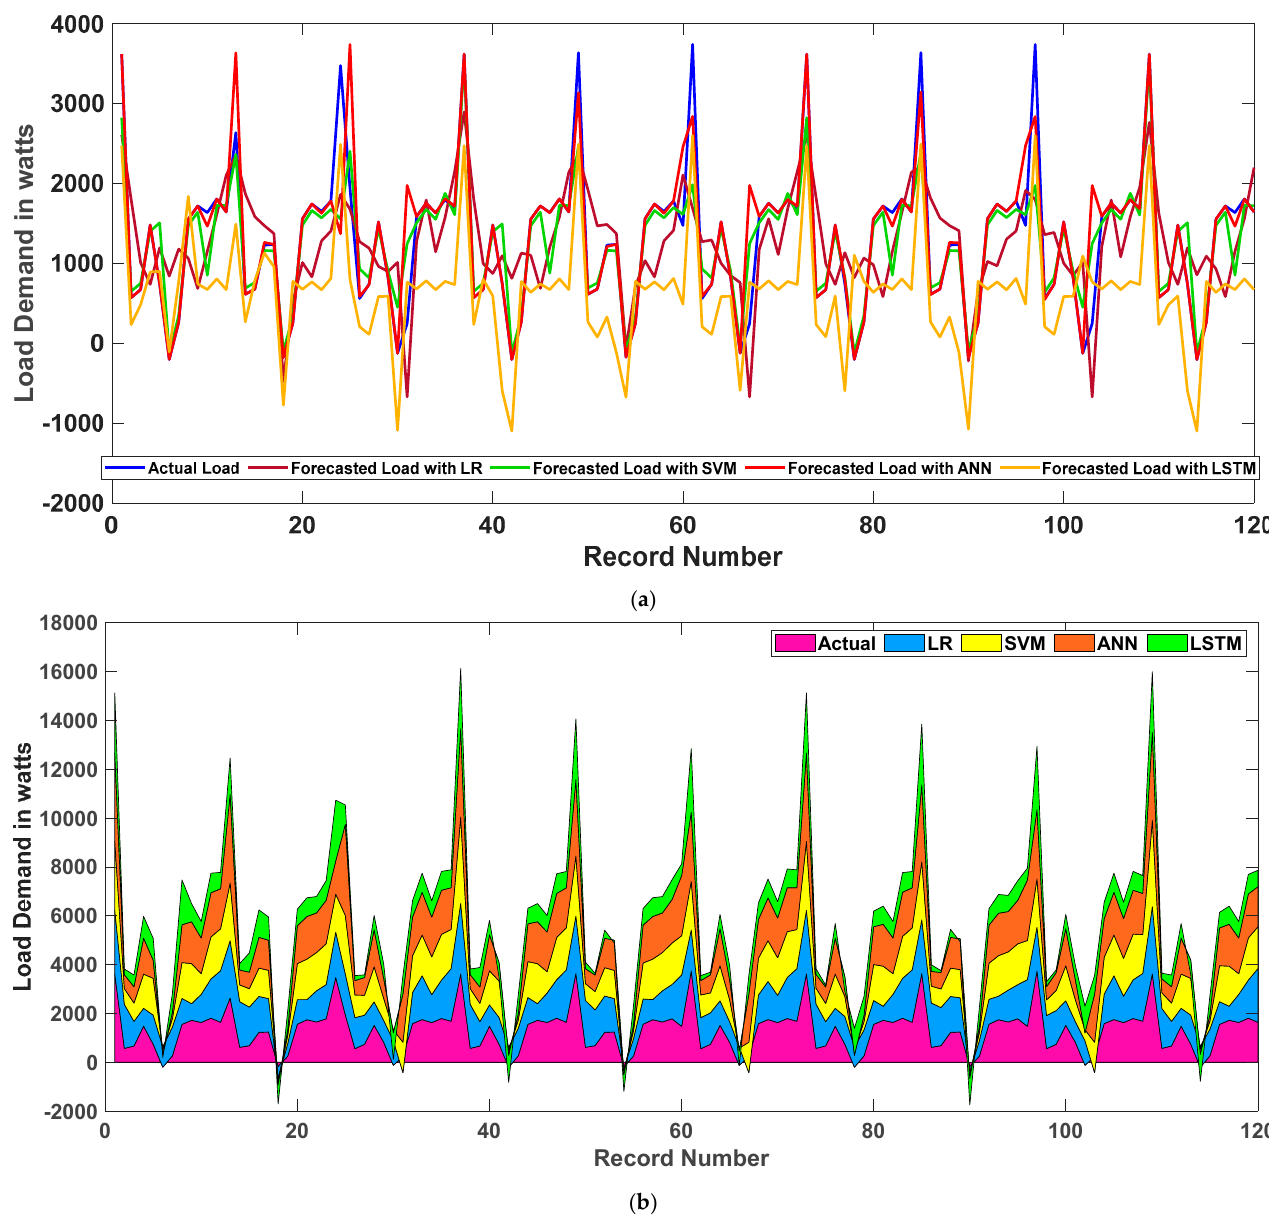
Figure 11. Cluster microgrid load profile plots. ( a ) Actual vs. forecasted load demands with LR (quadratic), SVM, ANN and LSTM. ( b ) Area plot with LR (quadratic), SVM, ANN, and LSTM. Table 2. Comparison of performance metrics computed for LR (quadratic), SVM, ANN, and LSTM.